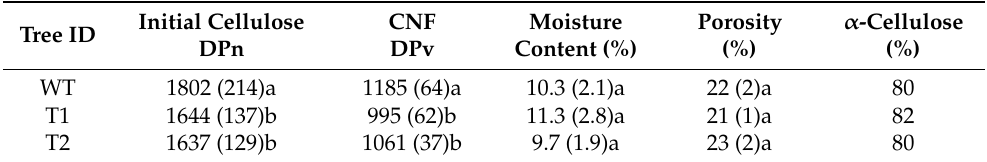
Table 2. Physical properties of the networks as determined prior to mechanical testing. Properties include average number degree of polymerization (DPn) for the initial wood cellulose (from Bünder et al., 2020), average viscosity degree of polymerization of final networks, moisture content, network porosity, and cellulose content. α -Cellulose Initial Cellulose CNF Moisture Porosity Tree ID DPn DPv Content (%) (%) (%) WT 1802 (214)a 1185 (64)a 10.3 (2.1)a 22 (2)a 80 T1 1644 (137)b 995 (62)b 11.3 (2.8)a 82 T2 1637 (129)b 1061 (37)b 9.7